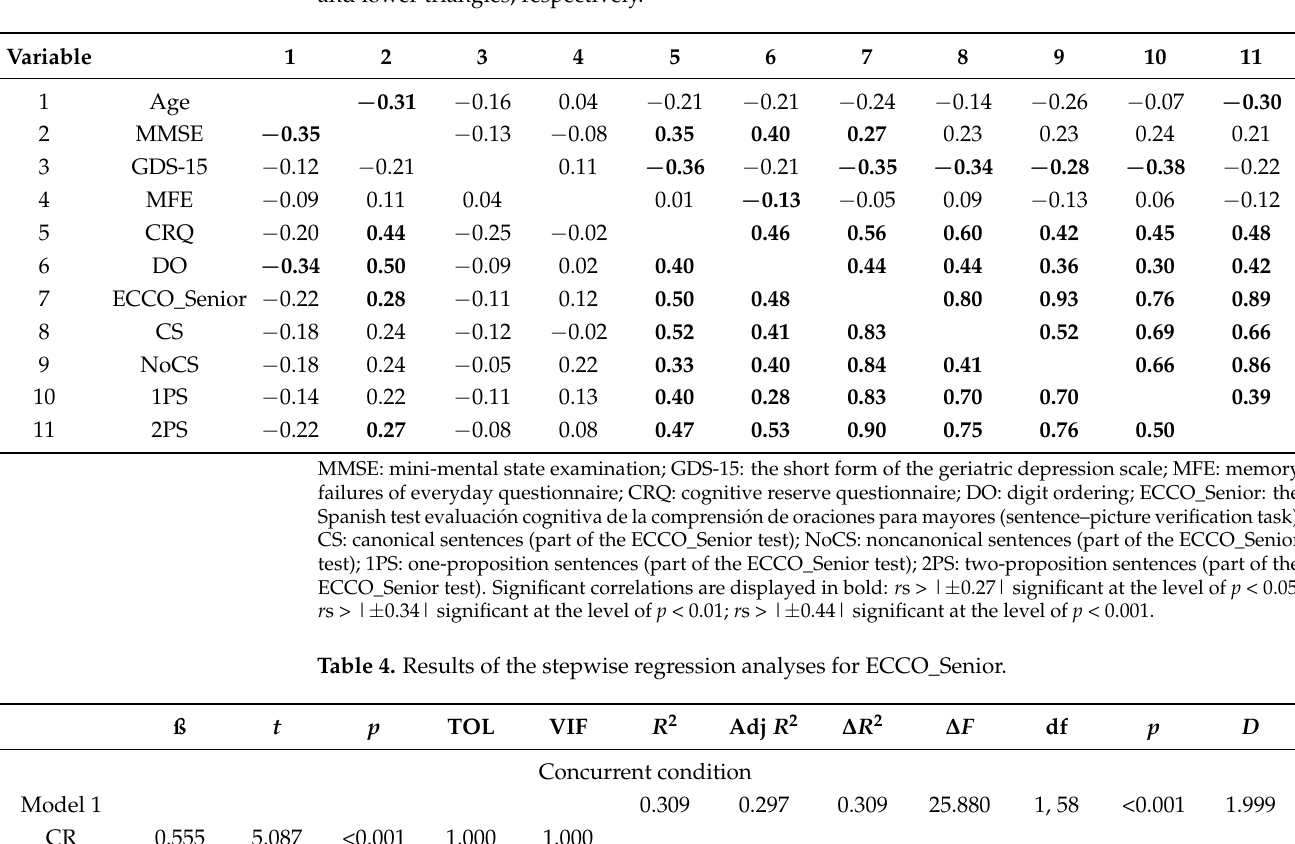
Table 3. Correlation matrix by group: coefficients for concurrent and serial conditions on the upper and lower triangles, respectively.